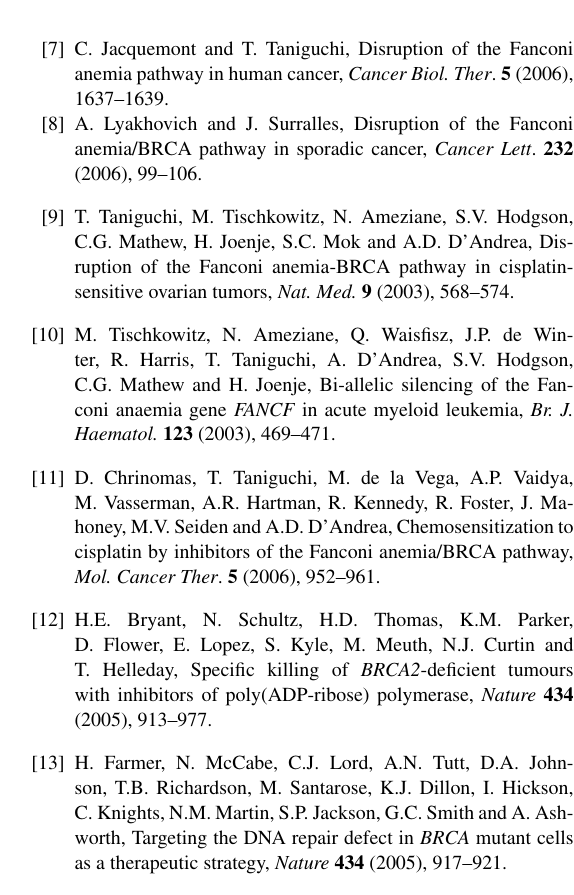
Fig. 1. Proteins participating in the FA pathway of genomic maintenance. The majority of FA proteins form the FA protein core complex, which is essential for the monoubiquitination of FANCD2 and referred to as the ‘upstream’ part of the pathway. The core complex consists of different subcomplexes (A/G, B/L, E/C/F) which assemble around the DNA translocase FANCM. The FANCE protein recruits FANCD2 to the core complex and allows the E3-ligase FANCL to monoubiquitinate FANCD2. FANCI is essential for the monoubiquitination step, but seems to act independently of the core complex, by tethering FANCD2 to the chromatin. FANCD1/BRCA2, FANCJ/BRIP1 and FANCN/PALB2 act downstream of the FA core complex, but co-localise with FANCD2 in DNA repair foci. All 13 proteins shown in this scheme cause, when defective, the syndrome Fanconi